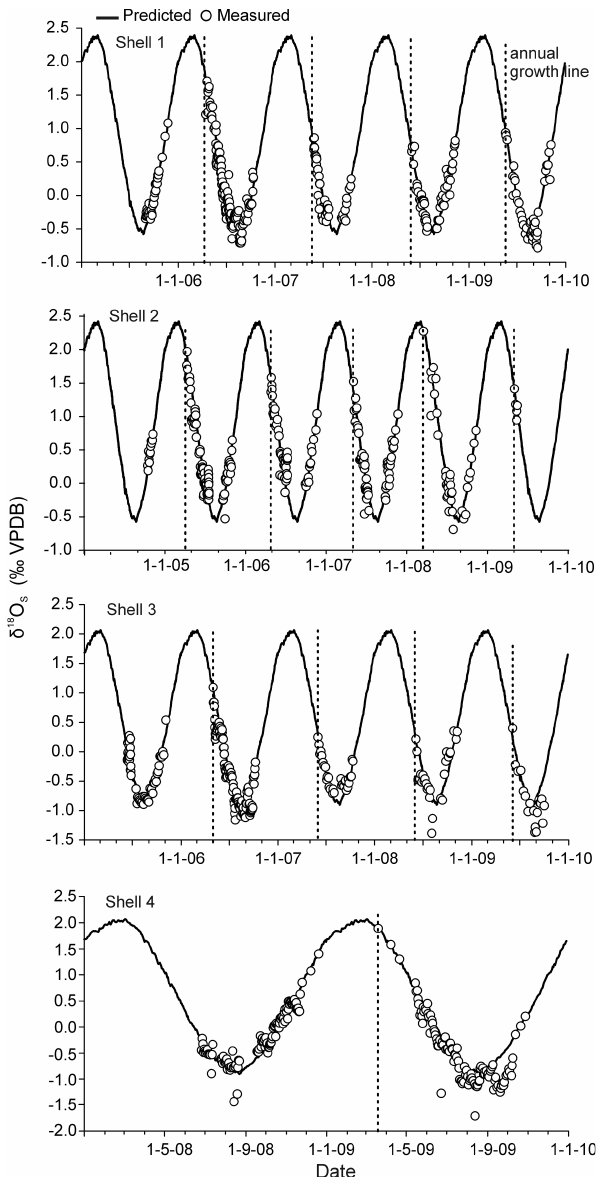
Fig. 3. Comparison of measured and predicted δ 18 O values in E. di- rectus shells. Line represents predicted δ 18 O values according to Eq. (1) (see text); open circles represent measured values sampled along the valve. Vertical dotted lines represent annual growth lines observed on the surface of the shell and in the acetate peels.